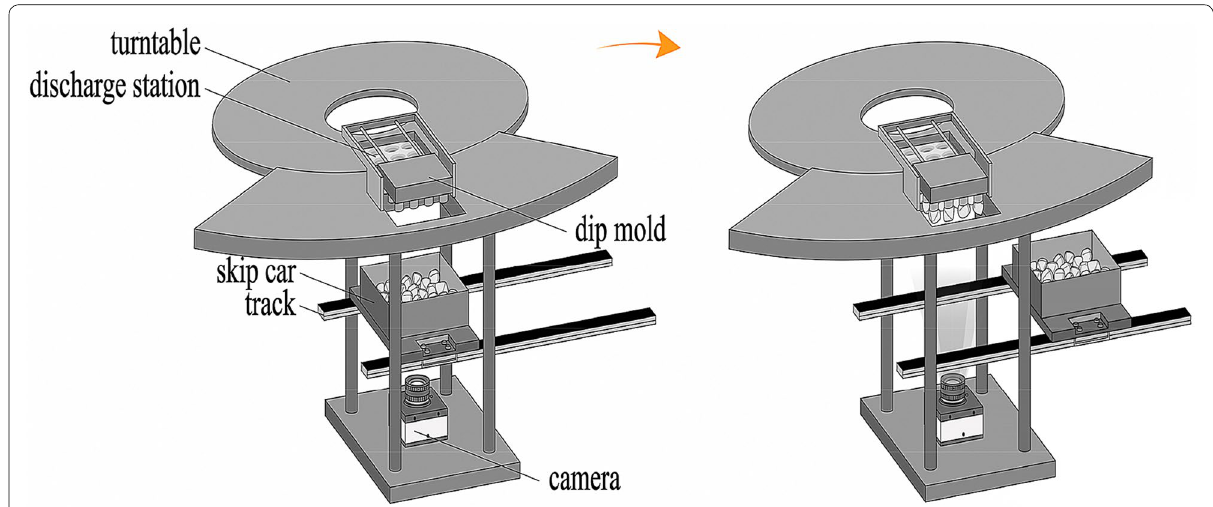
Figure 3 Schematic of online detection of diamond grit adsorption rate